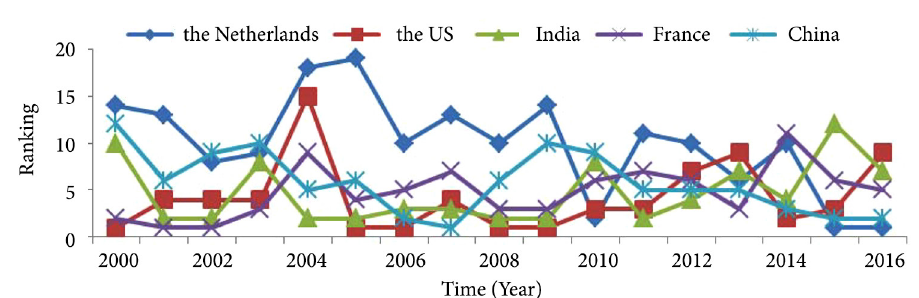
Figure 14. Evolution of the ranking of major trading